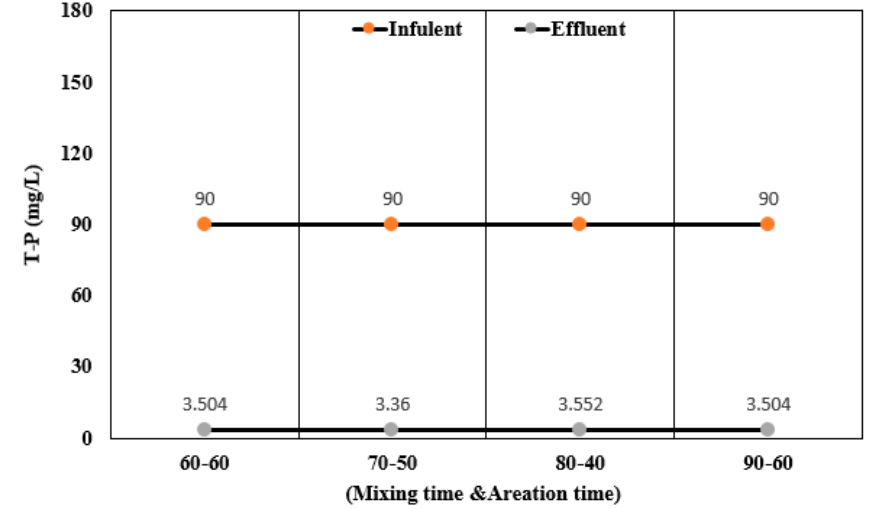
Figure 9. Raw water and treated water changes based on changes in mixing: aeration times (T-P).